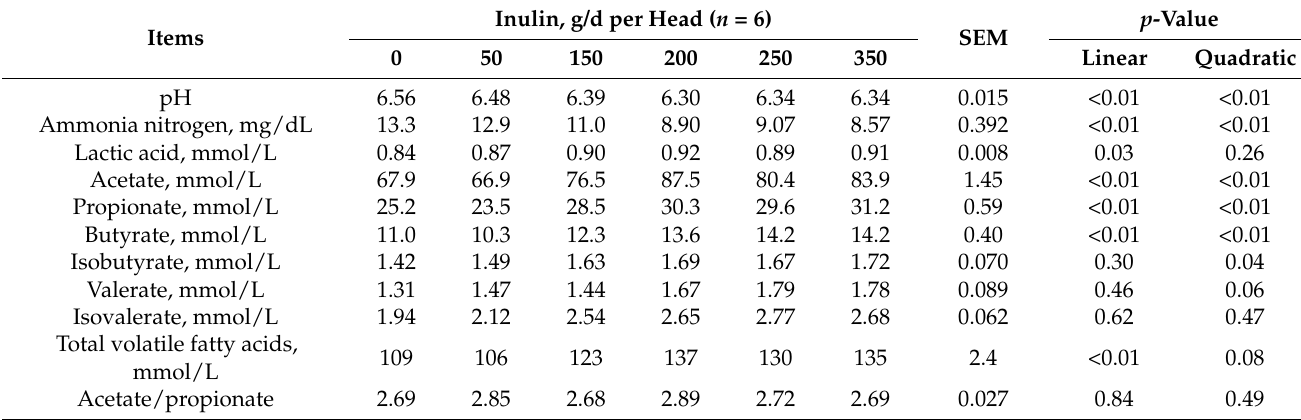
Table 2. Effects of inulin on rumen fermentation in dairy